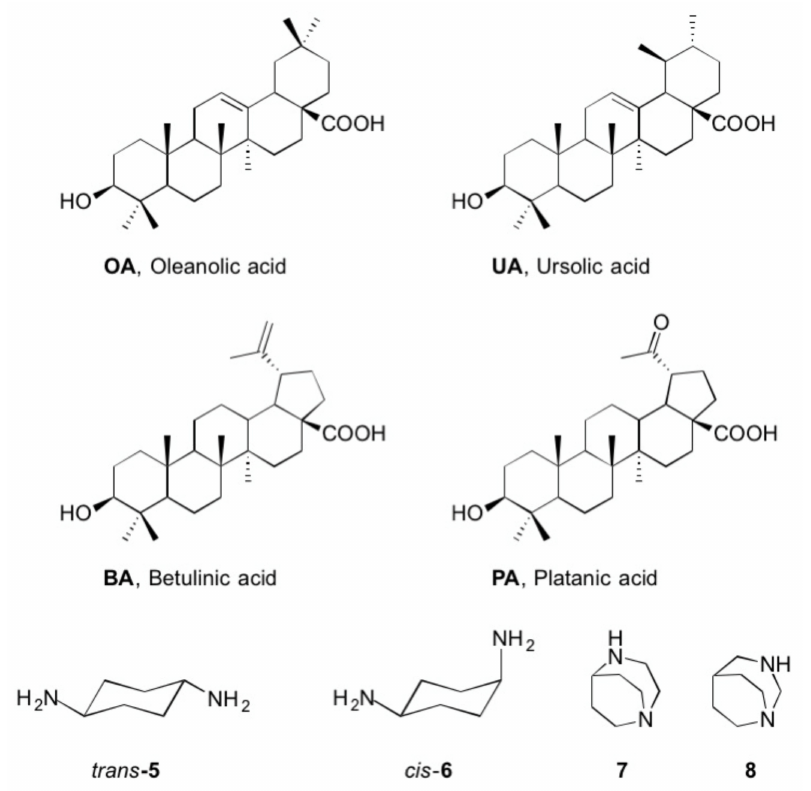
Figure 1. Structures of triterpenoic acids OA , UA , BA , and PA as well as of trans- and cis-1,4- cylohexyldiamines 5 and 6 , as well as bicyclic diamines 7 and 8 ,